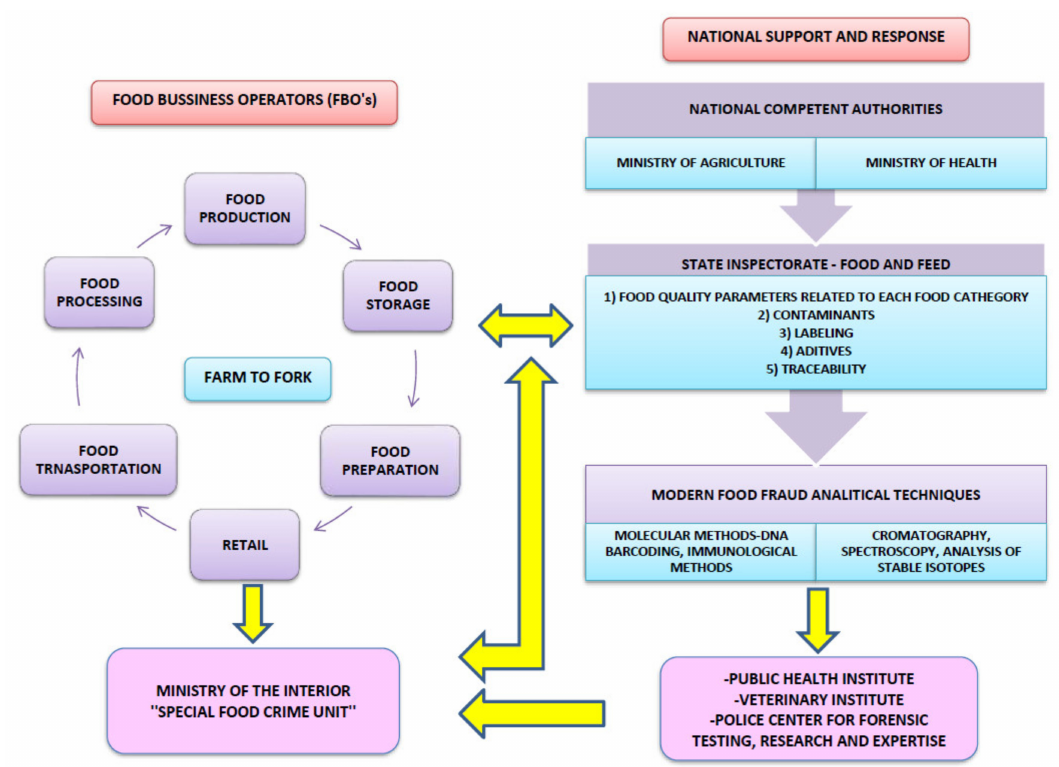
Figure 4. Responding to food fraud activities (Croatian